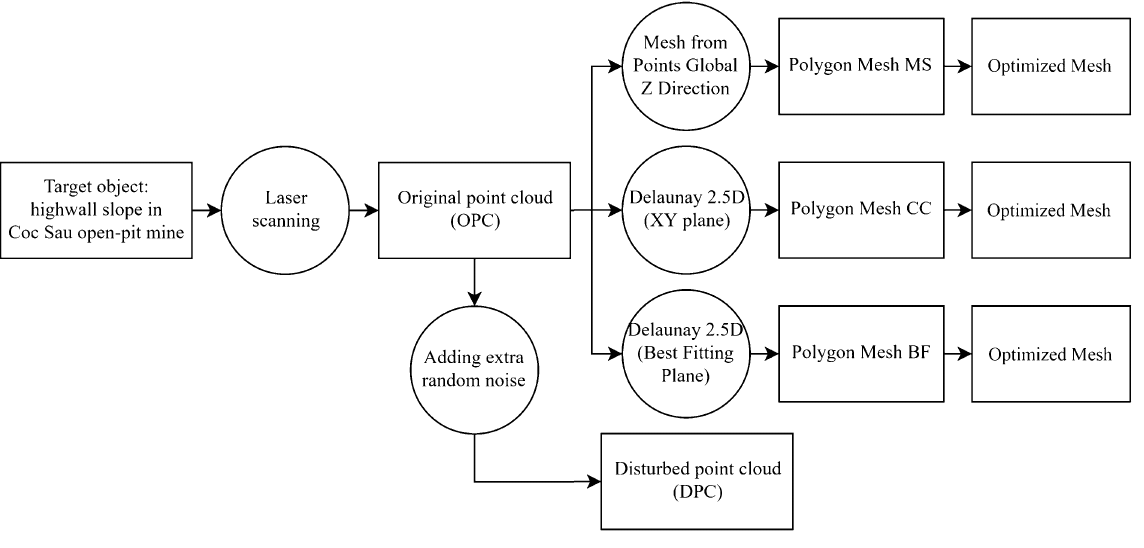
Fig. 6 The Coc Sau open-pit mine case study